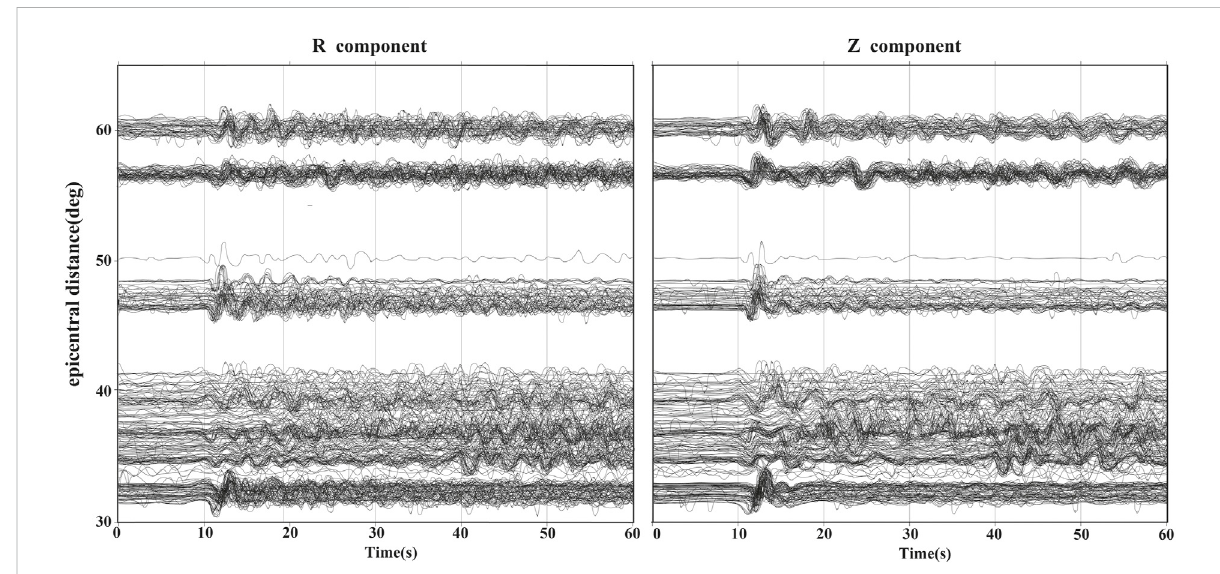
FIGURE 2 Observed teleseismic waveforms of R and Z components (after 0.02 – 2 Hz bandpass fi